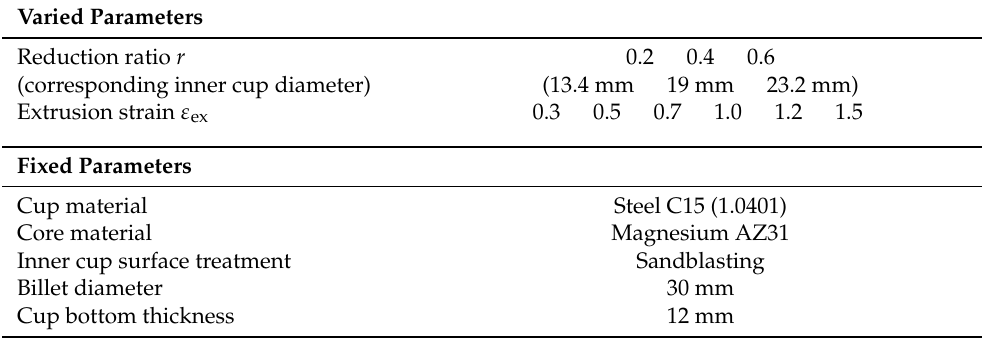
Table 1. Investigated parameters in composite cold forging with magnesium core